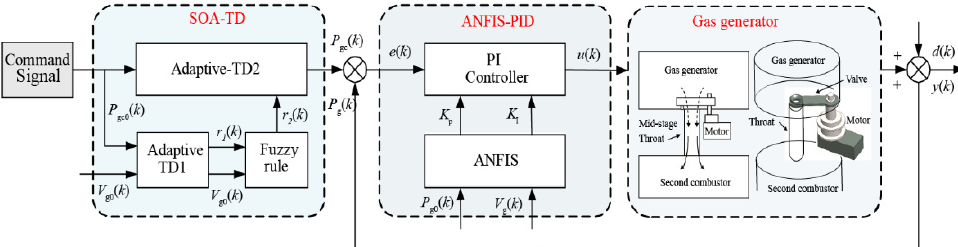
Figure 6. Schematic diagram of proposed SOA-ANFIS-PI controller.